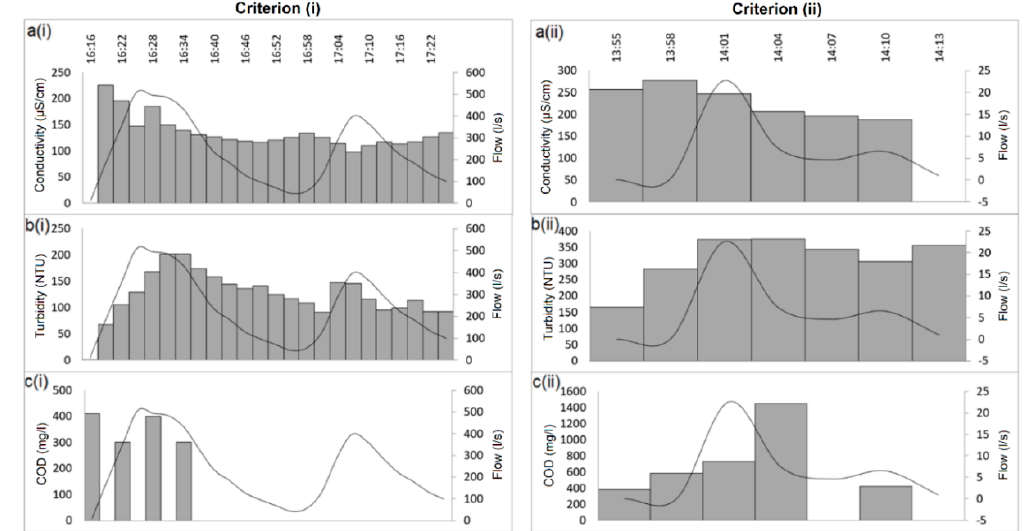
Figure A3. Variation of water quality parameters over time for the Coliseo CSO. Criterion ( i ) event with BOD 5 and COD values close to the mean. Criterion ( ii ) event with high BOD 5 and COD values. ( a ) conductivity, ( b ) turbidity and ( c ) COD.